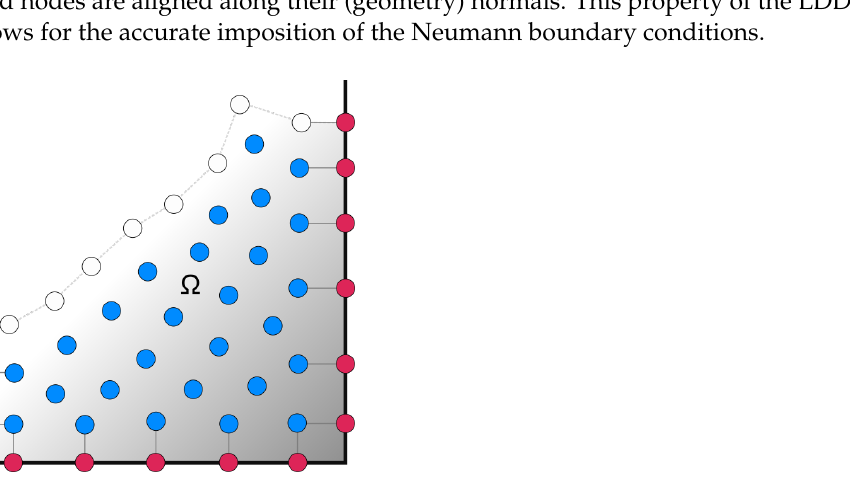
Figure 2. Inner fluid nodes (blue) and boundary conditions, i.e., wall nodes (red) and free surface nodes